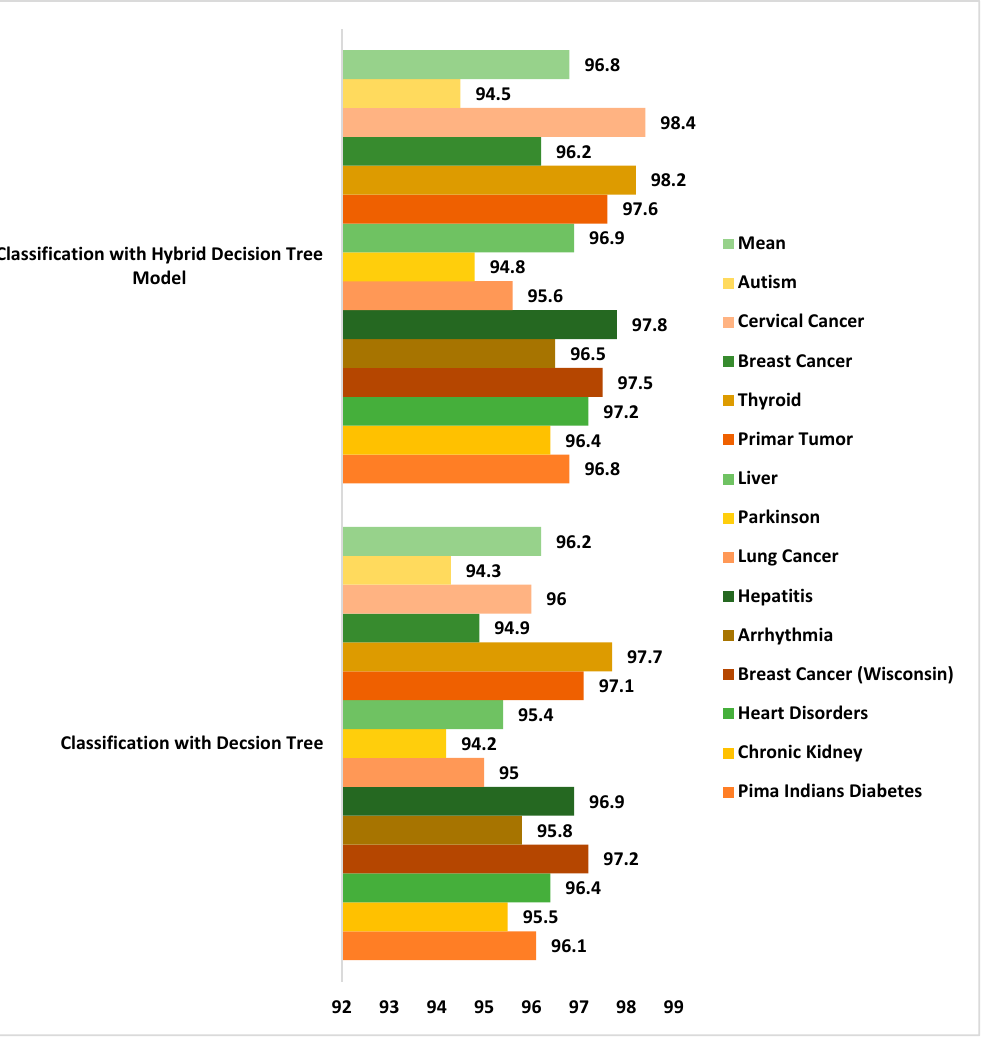
Figure 21. Comparison of accuracy rate between the Proposed Hybrid Decision Tree and the classical decision tree method on chronic disease datasets.